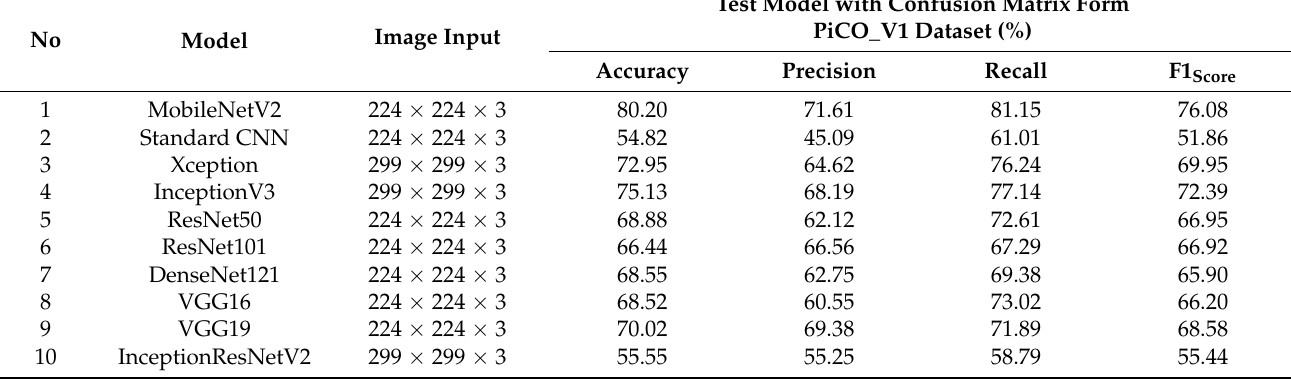
Table 7. Results of model accuracy from the confusion matrix of the PiCO_V1